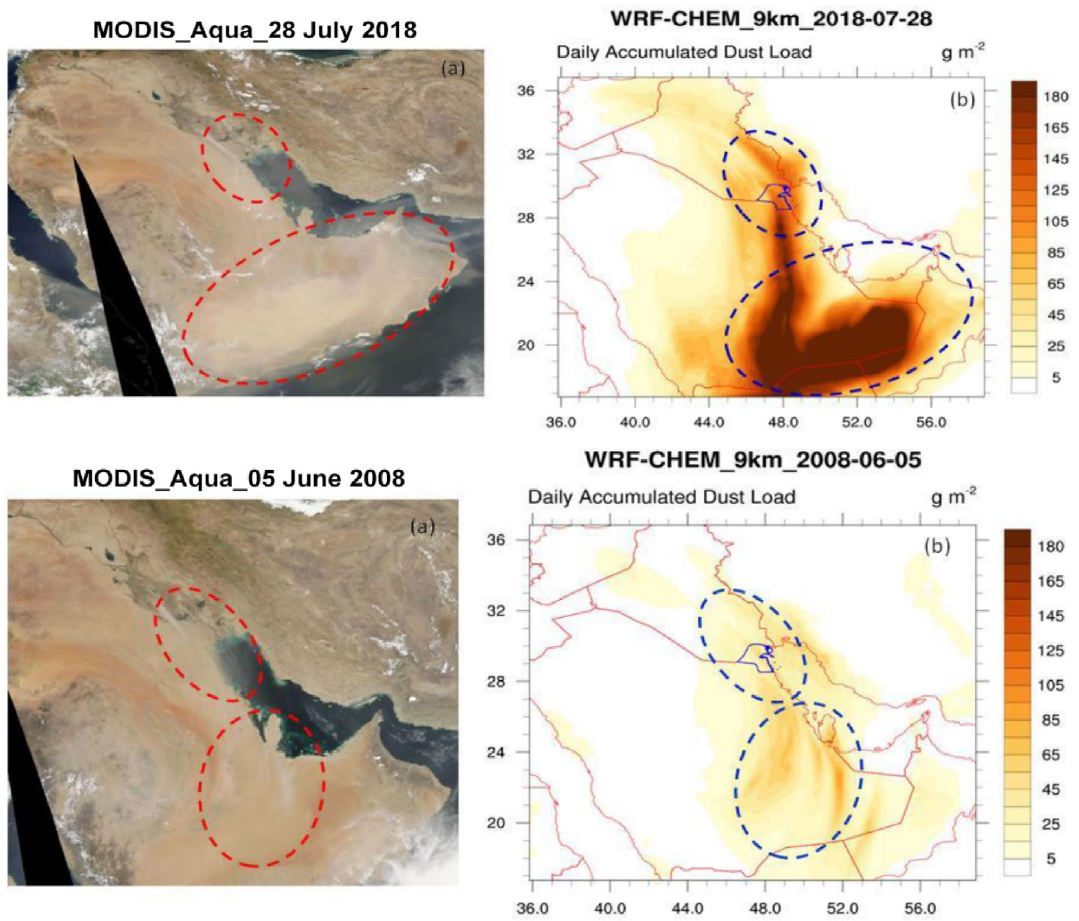
Fig. 5 Dust load hazard map for Kuwait based on a a strong dust storm on 28 July 2018; and b a moderate dust storm on 5 June 2008. Source Kuwait Institute for Scientific Research